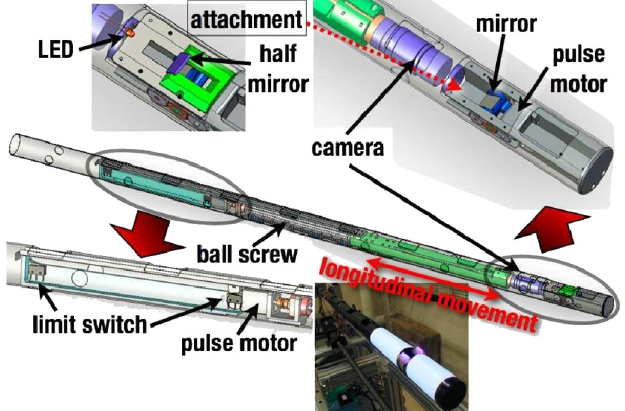
FIG. 2. (Color) Inside of the camera cylinder. The inset shown in upper right corner shows the mirror and its drive PM. The camera moves for focal adjustment. The EL sheets for the illumination are shown at the bottom.